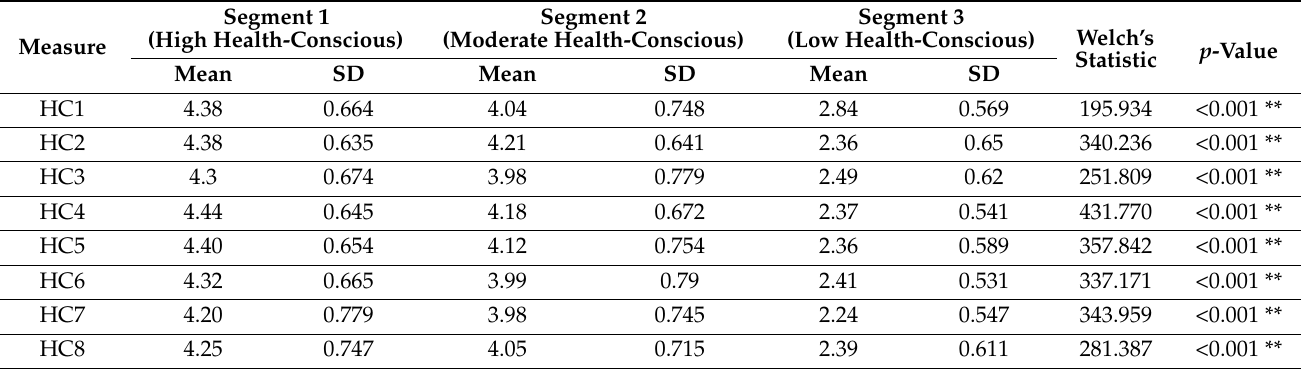
Table 4. Means and SDs classified by segments and Welch’s ANOVA test results.